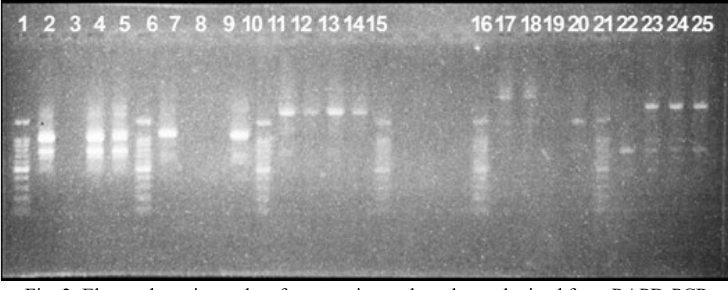
Fig. 2: Electrophoresis results of non-conjugated products obtained from RAPD-PCR Column 1: Marker, Columns 2 to 5: Primer OPA09, Column 6: Marker, Columns 7 to 10: OPA10, Column 11: Marker, Columns 12 to 15: OPC09, Column 16: Marker, Columns 17 to 20: OPS13, Column 21: Marker, Columns 22 to 25: OPS05